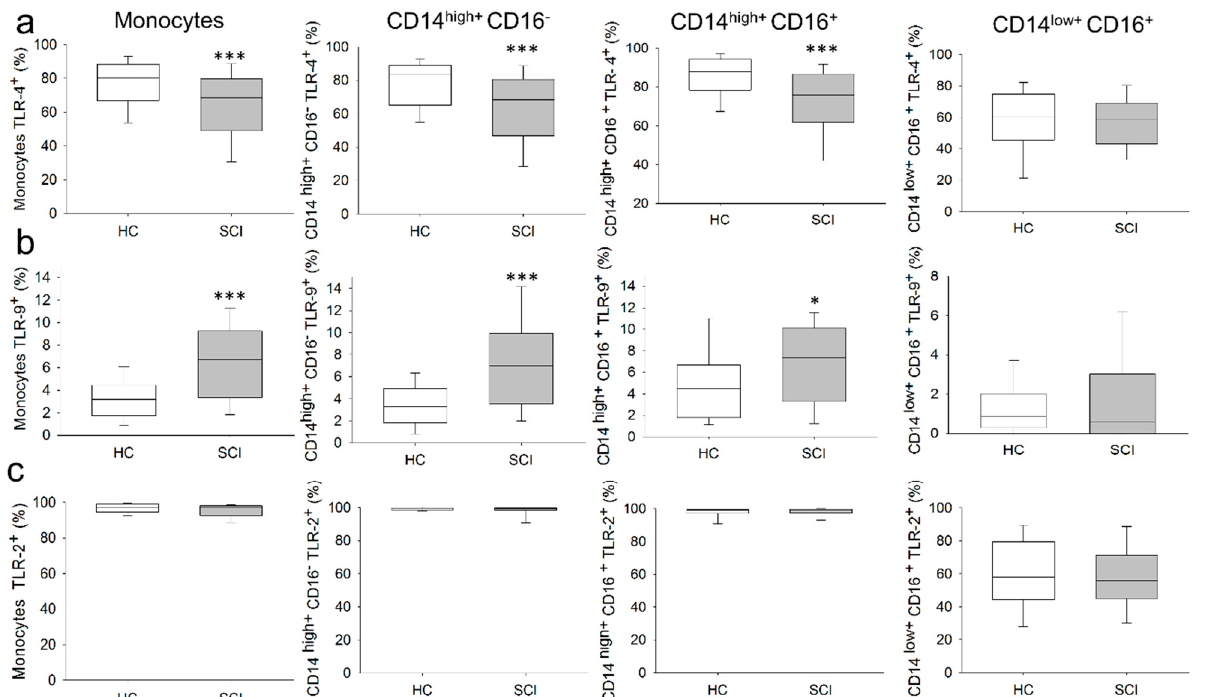
Figure 2. Expression of TLR4, TLR9 and TLR2 in circulating monocyte subsets from chronic SCI patients. Percentages of TLR4: ( a ) TLR9; ( b ) and TLR2; ( c ) in circulating monocytes and the CD14 +high CD16 − , CD14 +high CD16 + and CD14 +low CD16 + monocyte subsets from chronic SCI patients (gray box) and healthy controls (white box). * Significant difference between patients and healthy controls ( p < 0.05). *** Significant difference between patients and healthy controls ( p < 0.001).